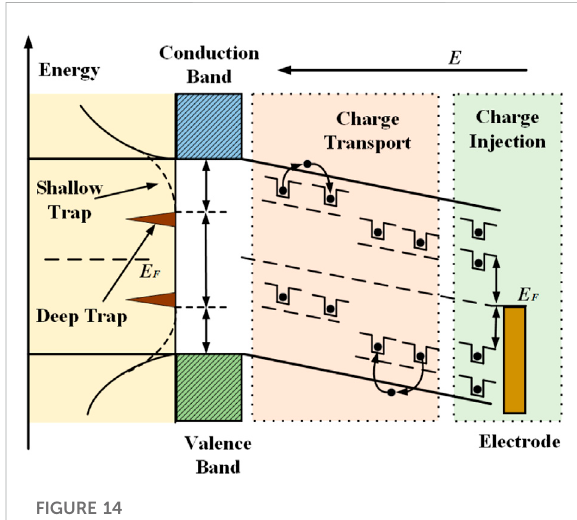
FIGURE 14 Charge injection and charge transport in